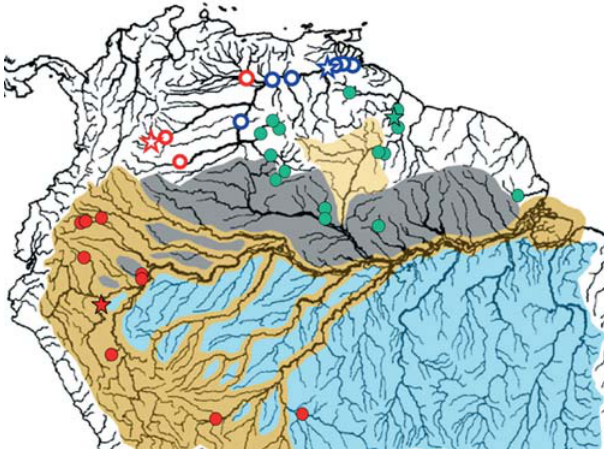
Fig. 16. Distributions of Leptodoras acipenserinus (solid red circles), L. linnelli (solid green circles), L. nelsoni (open red circles) and L. rogersae (open blue circles) (stars denote type